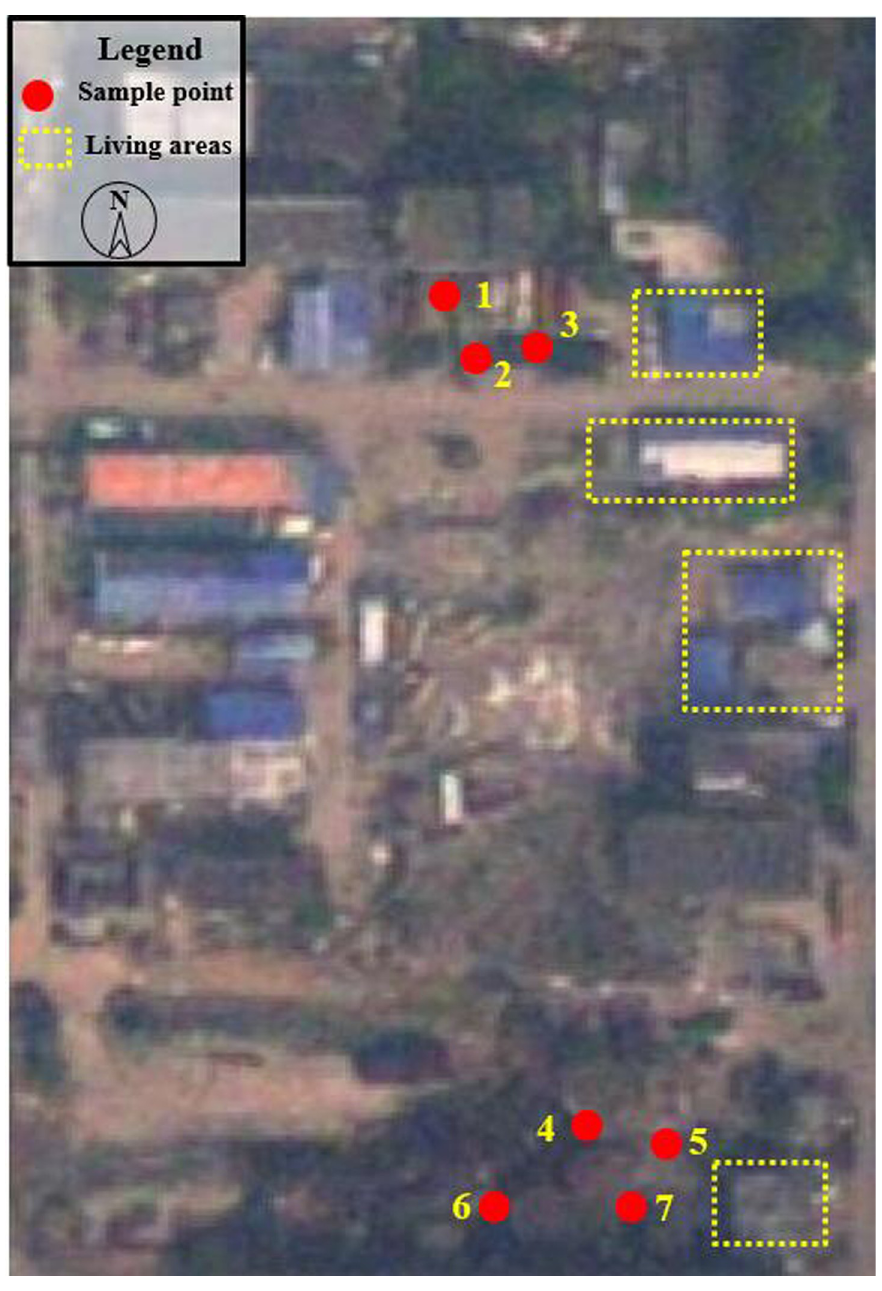
Fig 6. Satellite image of area A (The map was generated using free and open access data sources from National Platform for Common Geospatial Information Services. http://www.tianditu.gov.cn/).